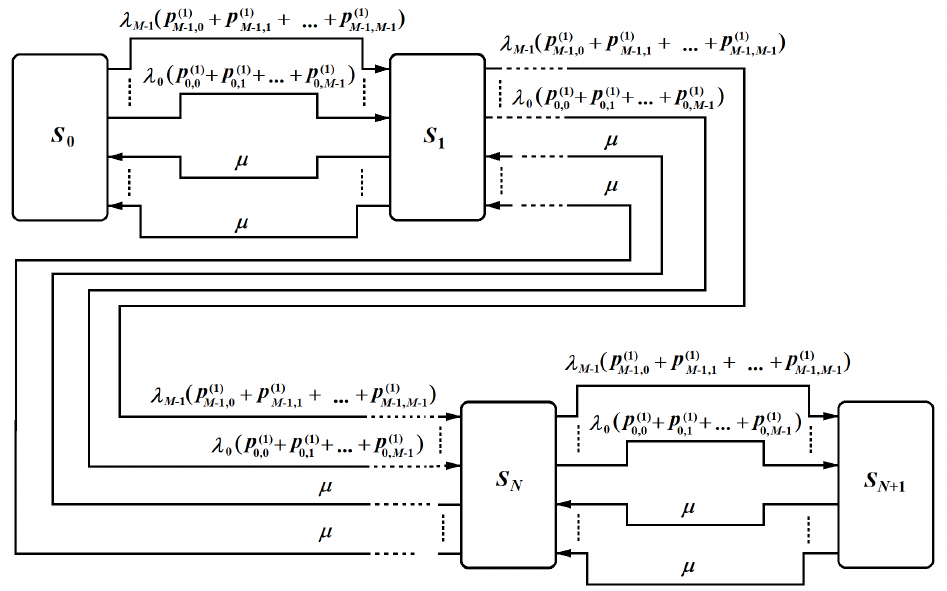
Figure 1. Generalized graph of the MAP / M /1/ N queuing